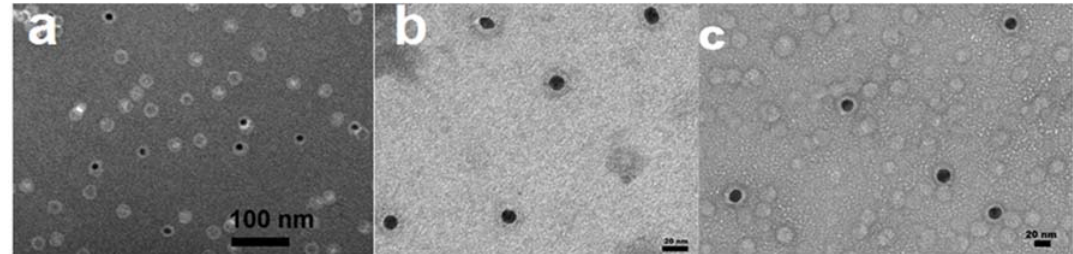
Figure 4. Negative stained TEM micrographs of 18 nm AuNP encapsidated by the CCMV CP at different conditions ( a ) pH = 3.6 and I = 0.1 M. ( b ) pH = 7 and I = 0.1 M and ( c ) pH = 4 and I = 0.02 M.